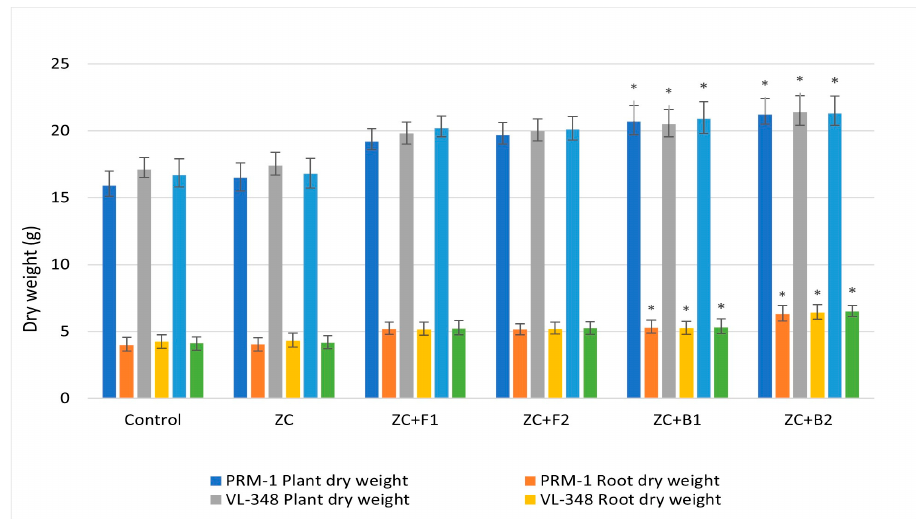
Figure 6. Endophyte inoculation in fl uencing plant and root dry weights. Error bars indicate the mean of triplicate experiments ± standard deviation. (ZC—Zinc carbonate; F1—EC1F-15; F2—EC1F-23; B1—EC3B-22; B2—EC3B-23.) * Indicates signi fi cate values at 5% probability.